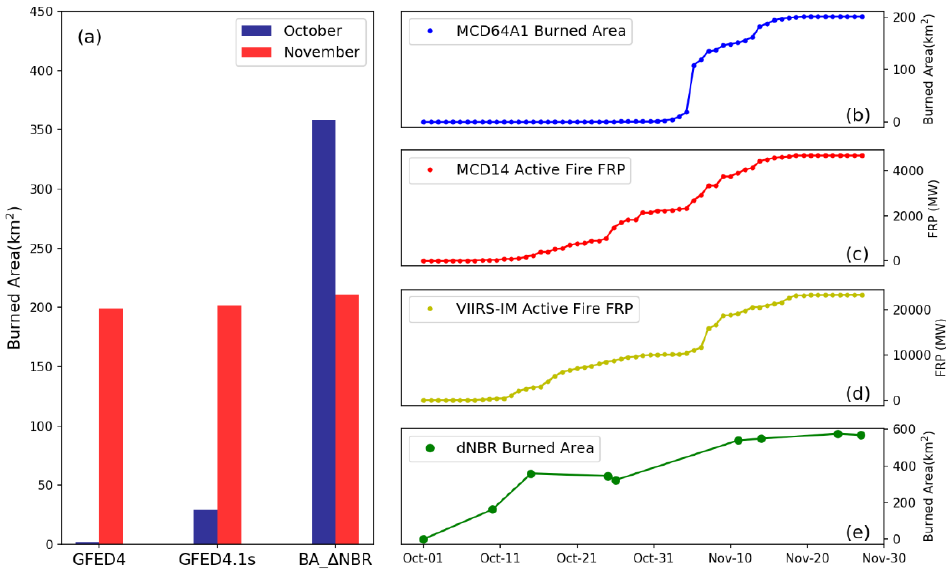
Figure 6. Total ( left column ) and cumulative time series ( right column ) of fire activity for October and November, 2016 for the 0.25 ° GFED grid cell located in the Punjab, north-western India (centred at 30.375° N, 74.875° E, shown spatially in Figure 7). ( a ) comparison of total BA in October (blue) and November (red) 2016 reported by GFED4 (based on MCD64A1) and GFED4.1s (based on MCD64A1 + the SFB of [11]), along with that derived from Landsat and Sentinel-2 dNBR-based BA mapping, and (right column) daily cumulative ( b ) MCD64A1 BA, ( c ) MCD14 FRP, ( d ) VIIRS-IM FRP, and ( e ) dNBR-derived BA from Landsat/Sentinel-2.